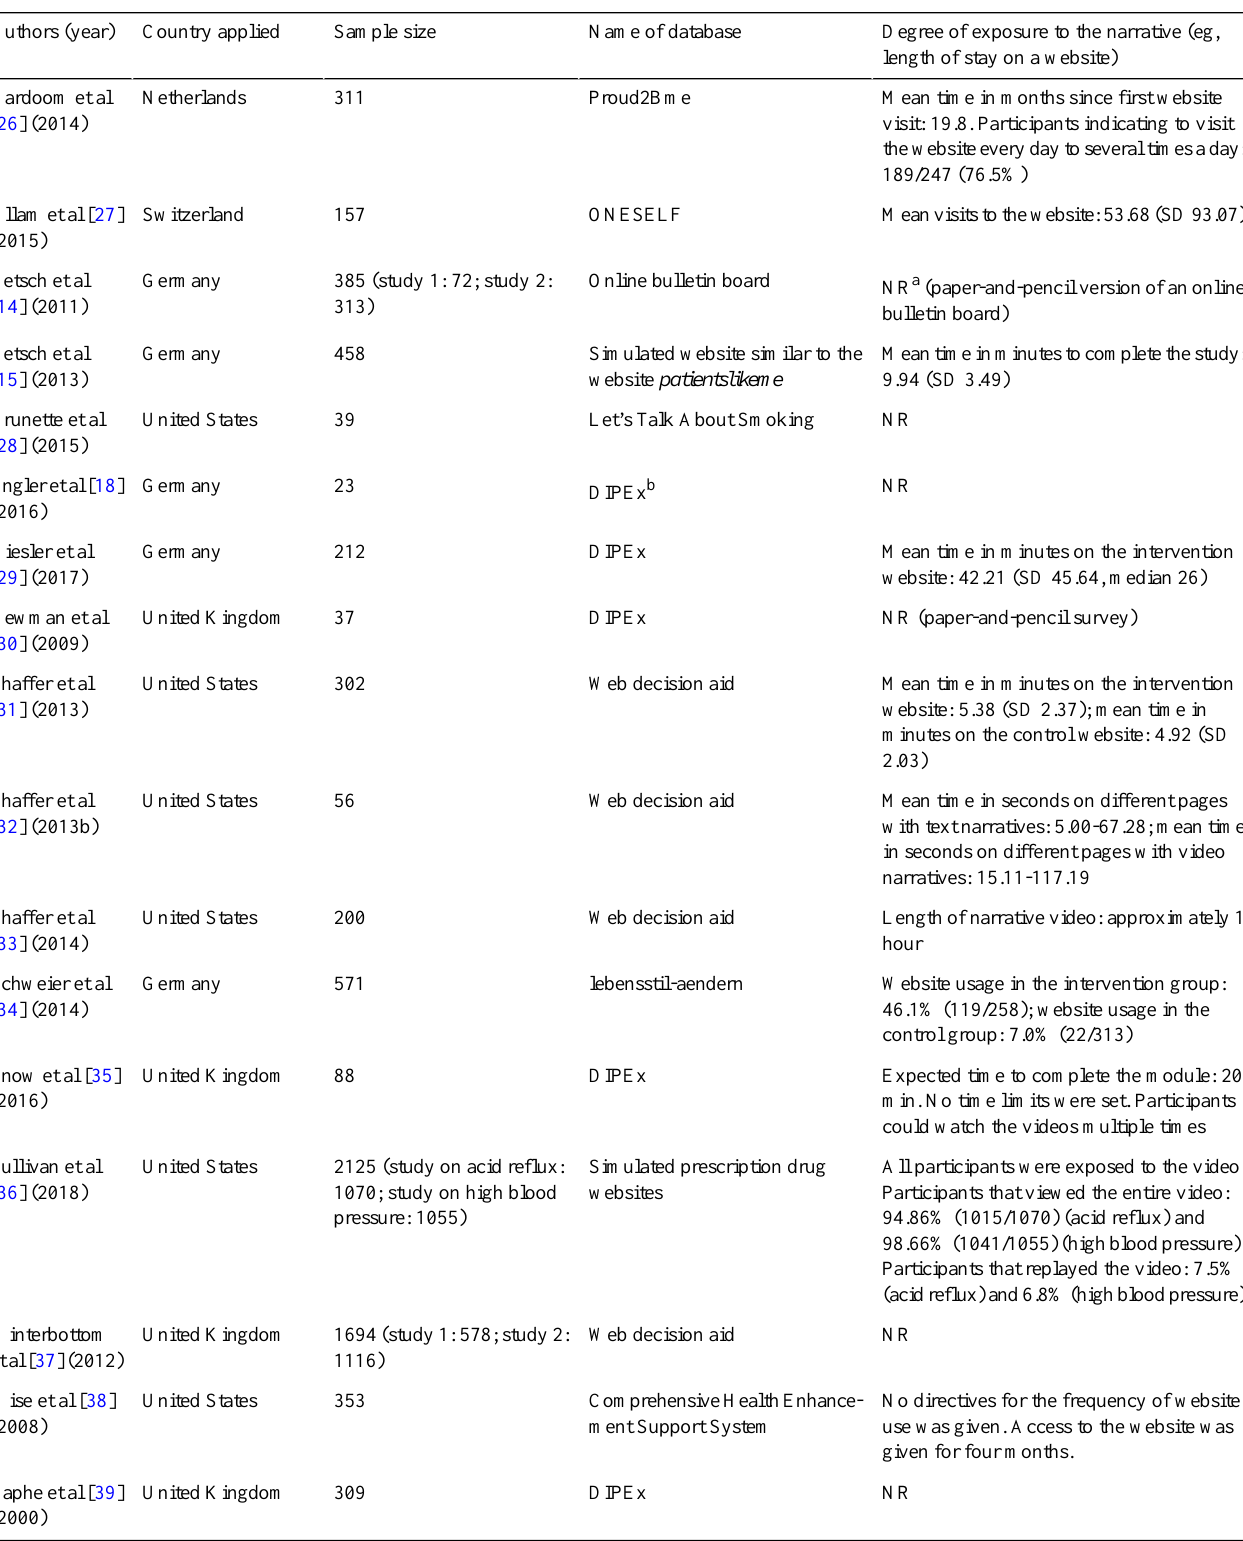
Table 2. Characteristics of the included studies.